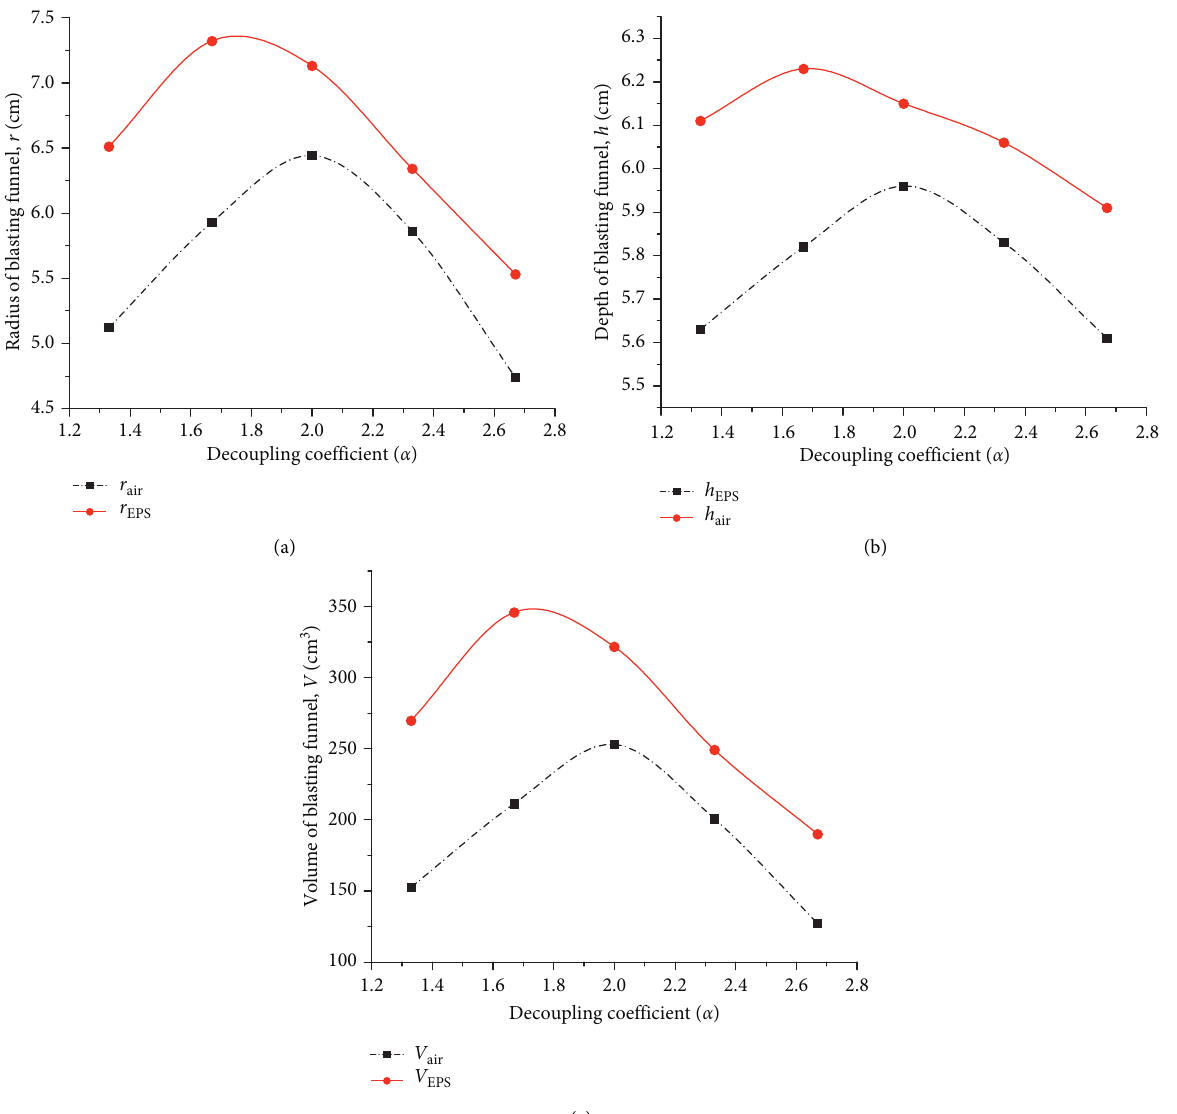
Figure 7: Relationships between geometric elements of the blasting funnel and the decoupling coefficient: (a) radius of the blasting funnel, (b) depth of the blasting funnel, and (c) volume of the blasting